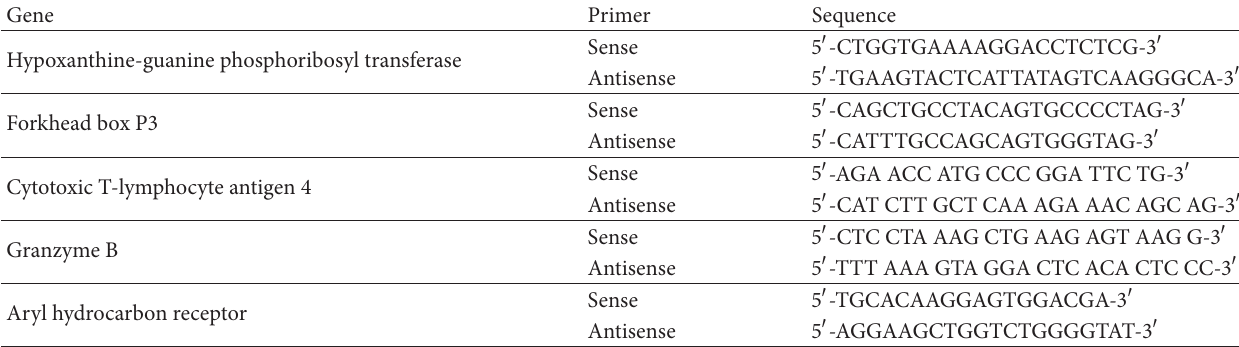
Table 1: Primer sequences used in this